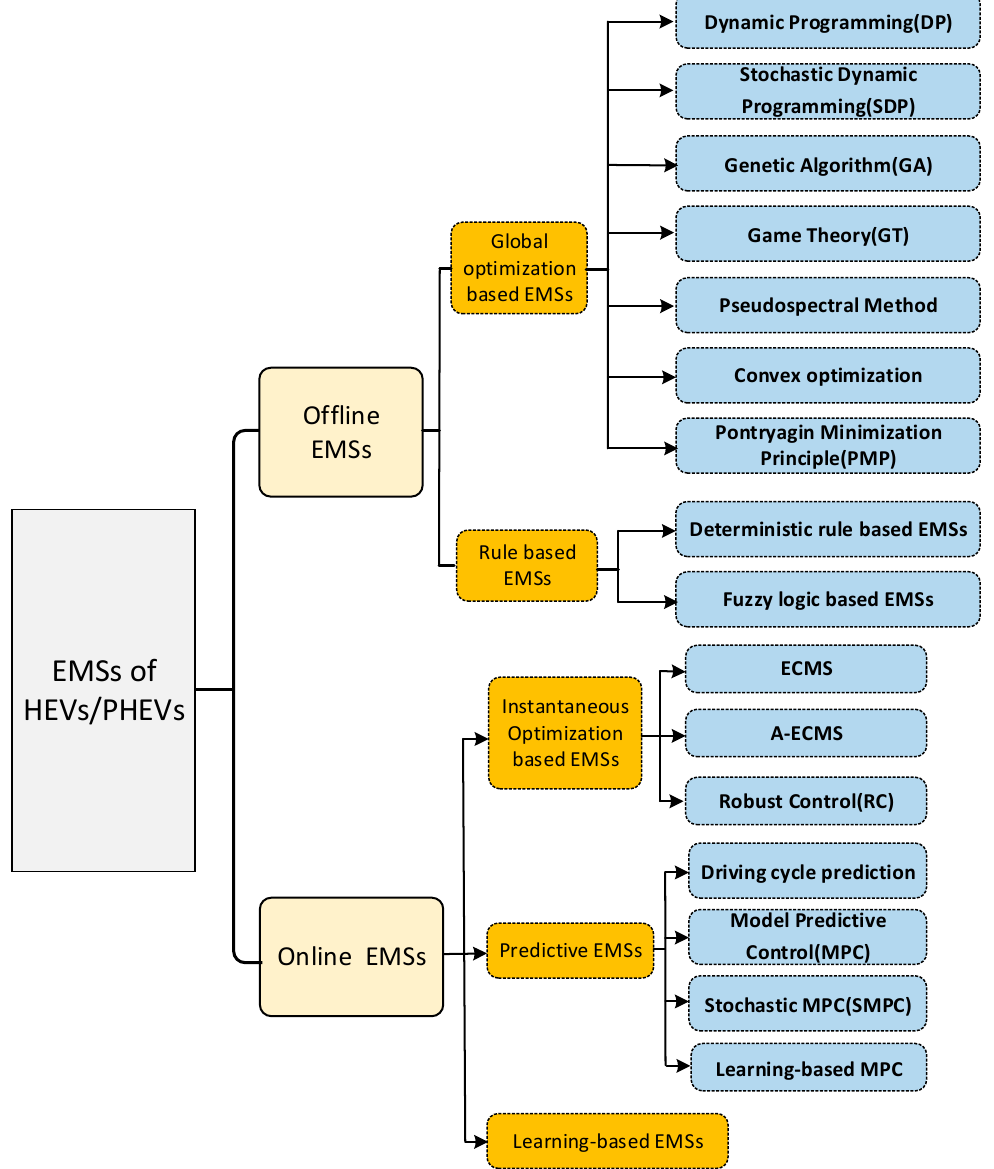
Figure 4. The proposed categorization of the energy management strategies.